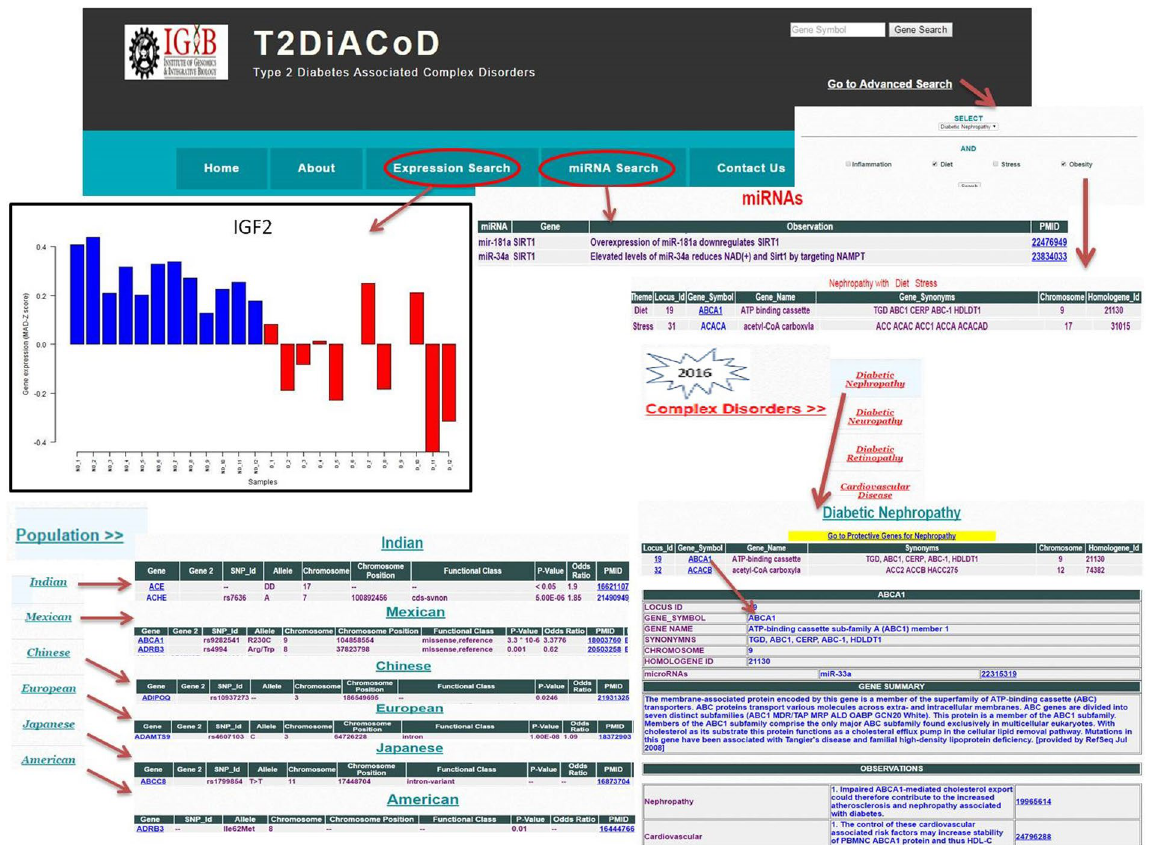
Figure 3. Visualization of T2DiACoD. The four sections of T2DiACoD are shown here as cropped screen shots. In T2DM complication, the nephropathy gene is displayed with gene summary (bottom right) and in the population section, example data for each of the populations in the database is shown. Histograms (top left) represent the differential expression of a gene IL6 . miRNAs with their corresponding genes and observations are displayed top middle. An example of combination search is presented - nephropathy with diet and